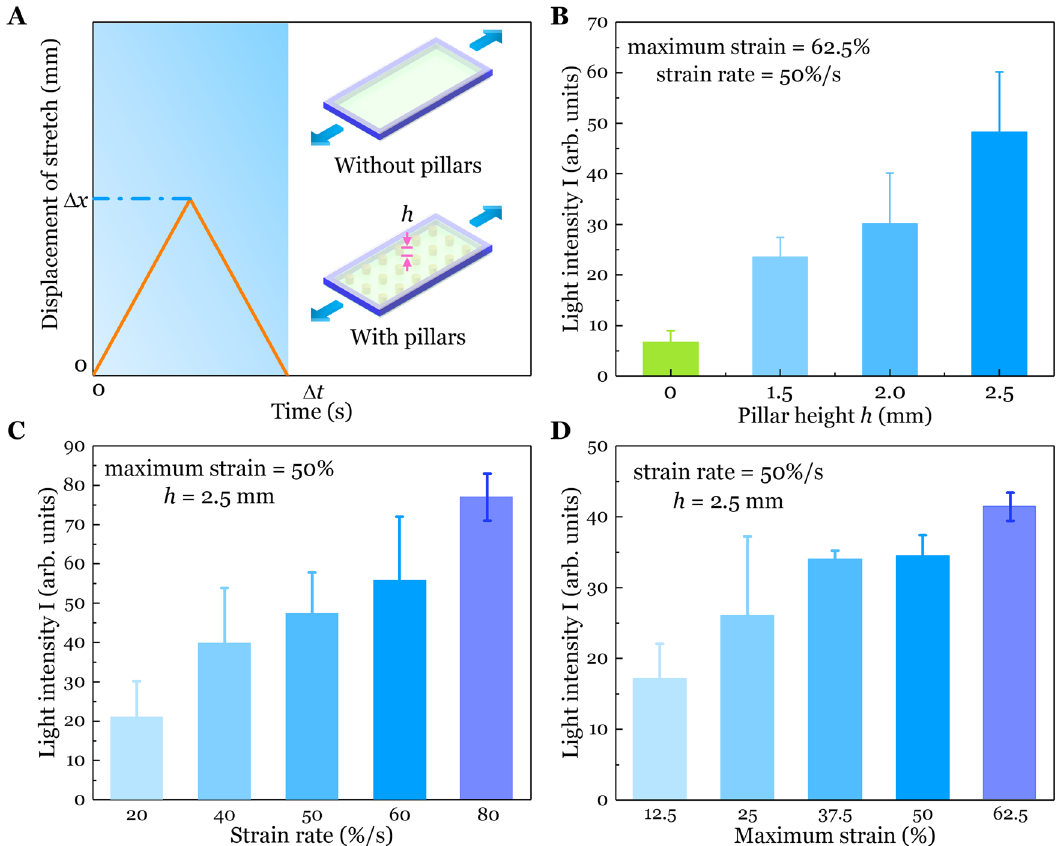
Fig. 3 Characterizations of the light intensity of biohybrid devices under various loading conditions. A The inset shows two kinds of chamber designs: “ Without pillars ” possesses a fl at surface for the bottom layers while “ With pillars ” contains cylindrical pillars with the height denoted by h to the bottom surface of the chamber. Chamber volume is kept the same for all con fi gurations. We applied one cycle of the triangle loading-unloading test to the devices with the maximum displacement as Δ x and period as Δ t . Light emission was derived from camera imaging of stimulated bioluminescence (see Methods for details). B Light intensity based on grayscale values of the stimulated bioluminescence increased as a function of the height of the pillars, with “ h = 0 mm ” referring to the chamber design without pillars. C Light intensity as a function of strain rate for a fi xed maximum strain of 50% for chambers with h = 2.5 mm pillars. D Light intensity as a function of maximum strain for a fi xed strain rate of 50% s − 1 for chambers with h = 2.5 mm pillars. Values in ( B ), ( C ), and ( D ) represent averages with standard deviations for N = 3